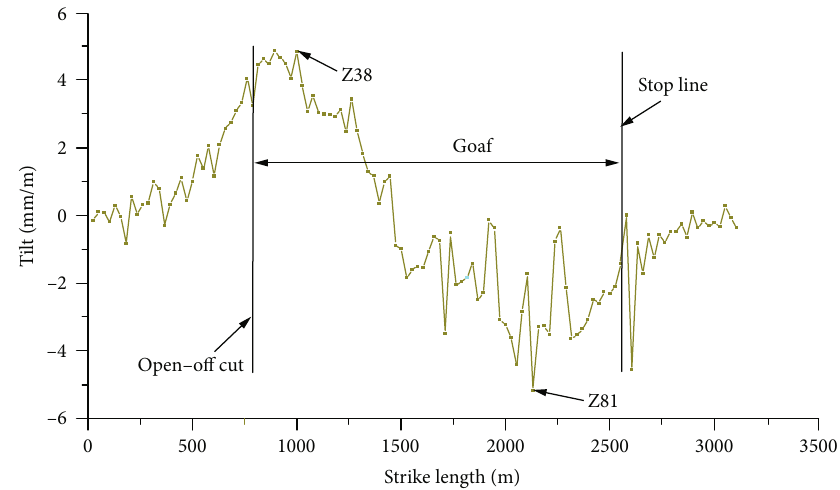
Figure 3: Surface inclination curve of 1301 working face towards the main section.